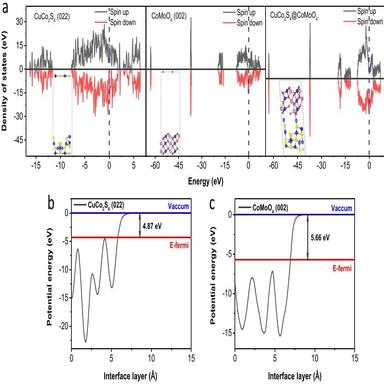
(a) Densities of states calculated for the CuCo2S4 (022), CoMoO4 (002), and CuCo2S4@CoMoO4 surfaces. Insets show the side views of the optimized models. (b) Potential lineup diagrams of the CuCo2S4 (022) and (c) CoMoO4 (002) surfaces (here, "E-fermi" denotes the Fermi level).